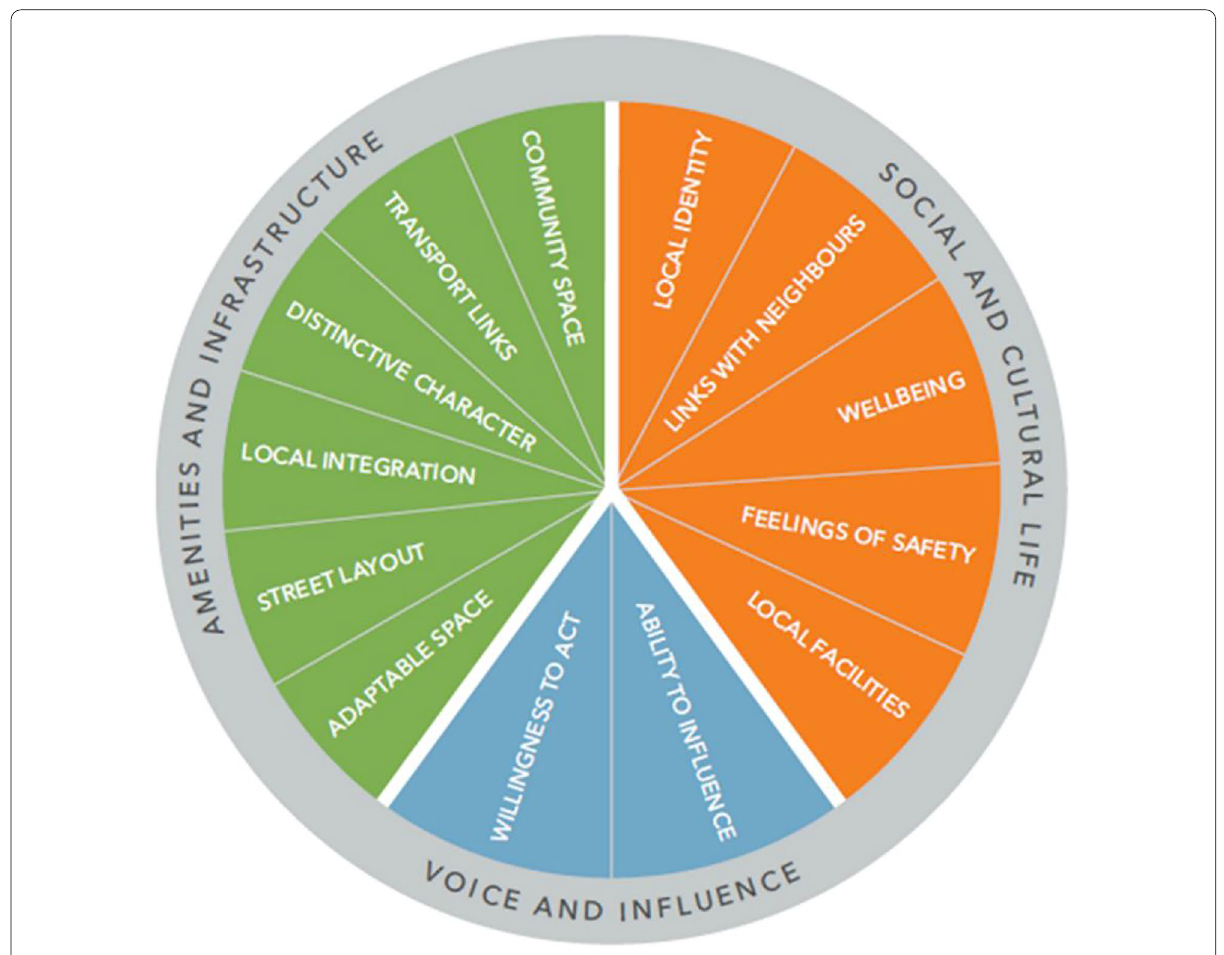
Fig. 11 Previous model (source: Burkeley Group 2014 [Woodcraft